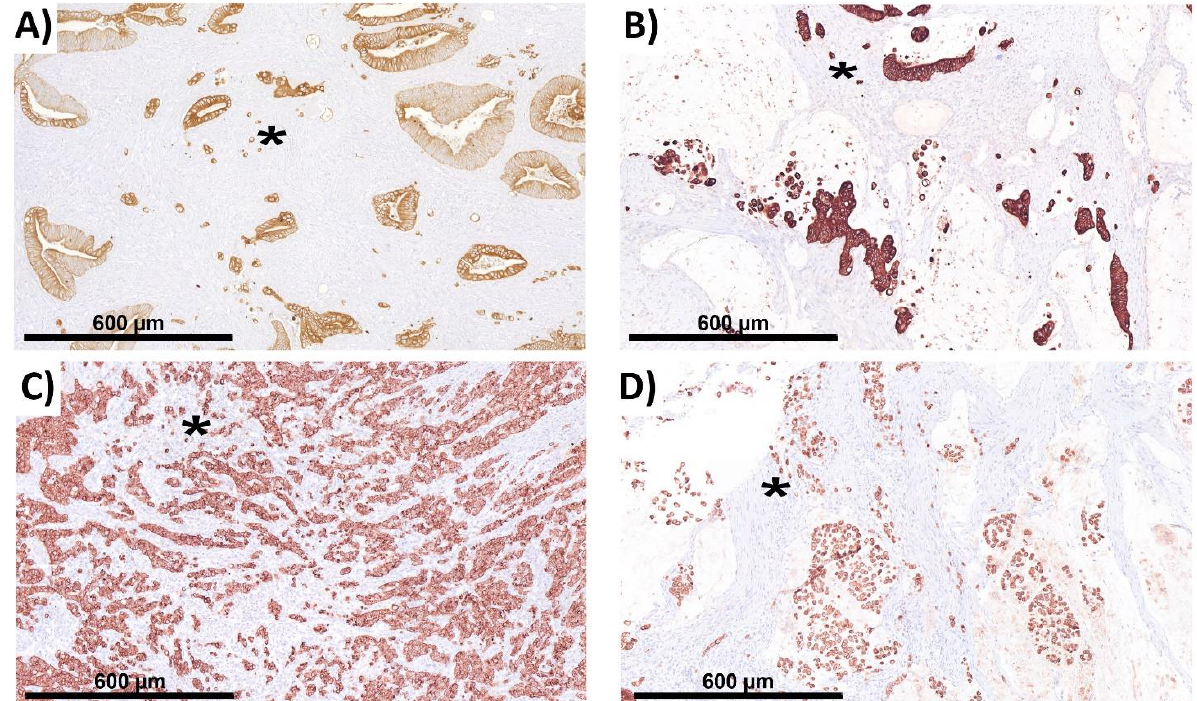
Figure 9. Histological subtypes. For technical data, see legend in Figure 1. All images were taken at 10 × magnification. All 4 analyzed subtypes are shown in A–D. ( A ) NOS, ( B ) mucinous carcinoma, ( C ) medullary carcinoma, and ( D ) signet ring cell carcinoma. Exemplary buds are marked with an asterisk (*), that are located in the stroma and that fulfil the given criteria for ITB.